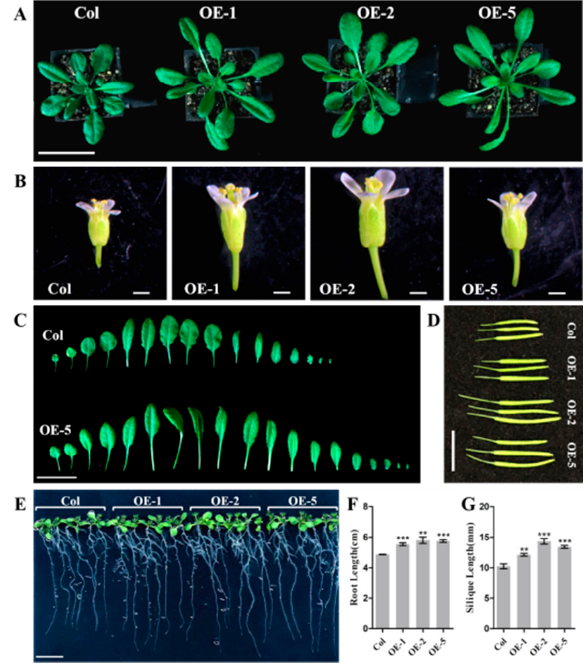
Figure 5. Ectopic expression of EjNACL47 enlarges organ size in Arabidopsis . ( A , C ) Phenotypic changes in transgenic Arabidopsis at 3 weeks of age. Scale bars, 5 cm and 3 cm, respectively. ( B ) Phenotypic changes in transgenic Arabidopsis flowers. Scale bar, 1 mm. ( D , E ) Comparison of fruit silique length and root length between wild-type and transgenic Arabidopsis , respectively. Scale bar, 1 cm. ( F , G ) Statistics on root length and silique length of wild-type and transgenic Arabidopsis , respectively. Error bars represent the standard deviation from five root-length measurements and 10 silique-length measurements, respectively. ** p < 0.01, *** p < 0.001.